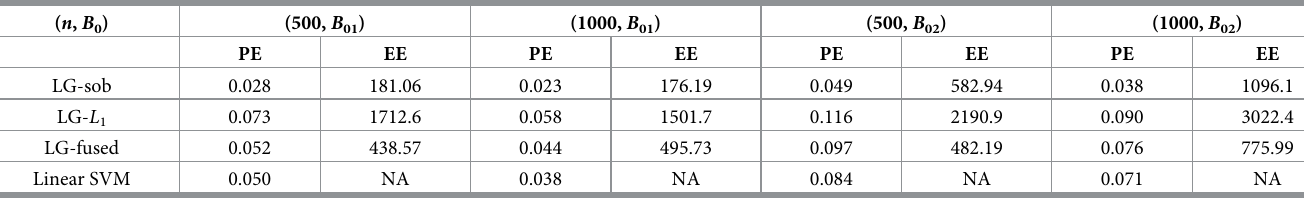
Table 2. Results of simulated example 2: Prediction error (PE) and estimation error (EE). ( n , B 0